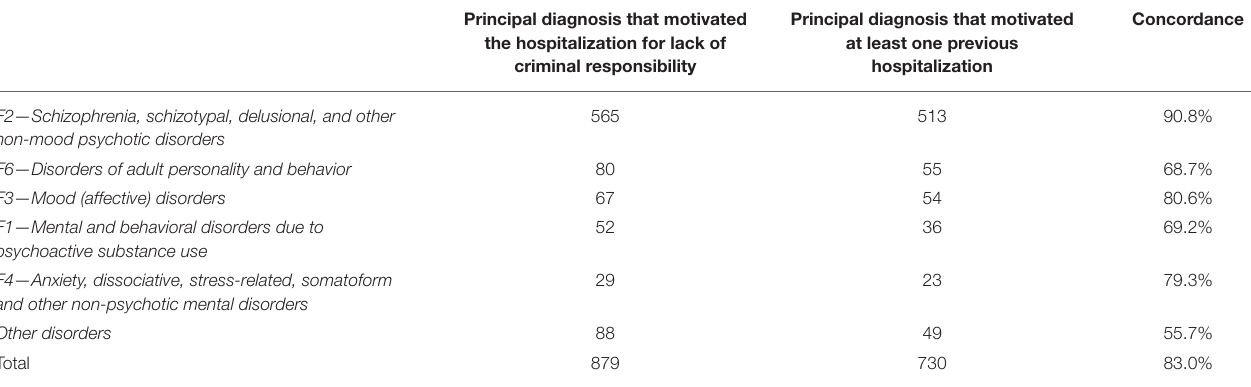
TABLE 3 | Principal diagnoses that motivated the hospitalization for lack of criminal responsibility and psychiatric hospitalizations during the previous 5 years for patients found not criminally responsible on account of mental disorder admitted after 2016 in France ( n = 879). Principal diagnosis that motivated the hospitalization for lack